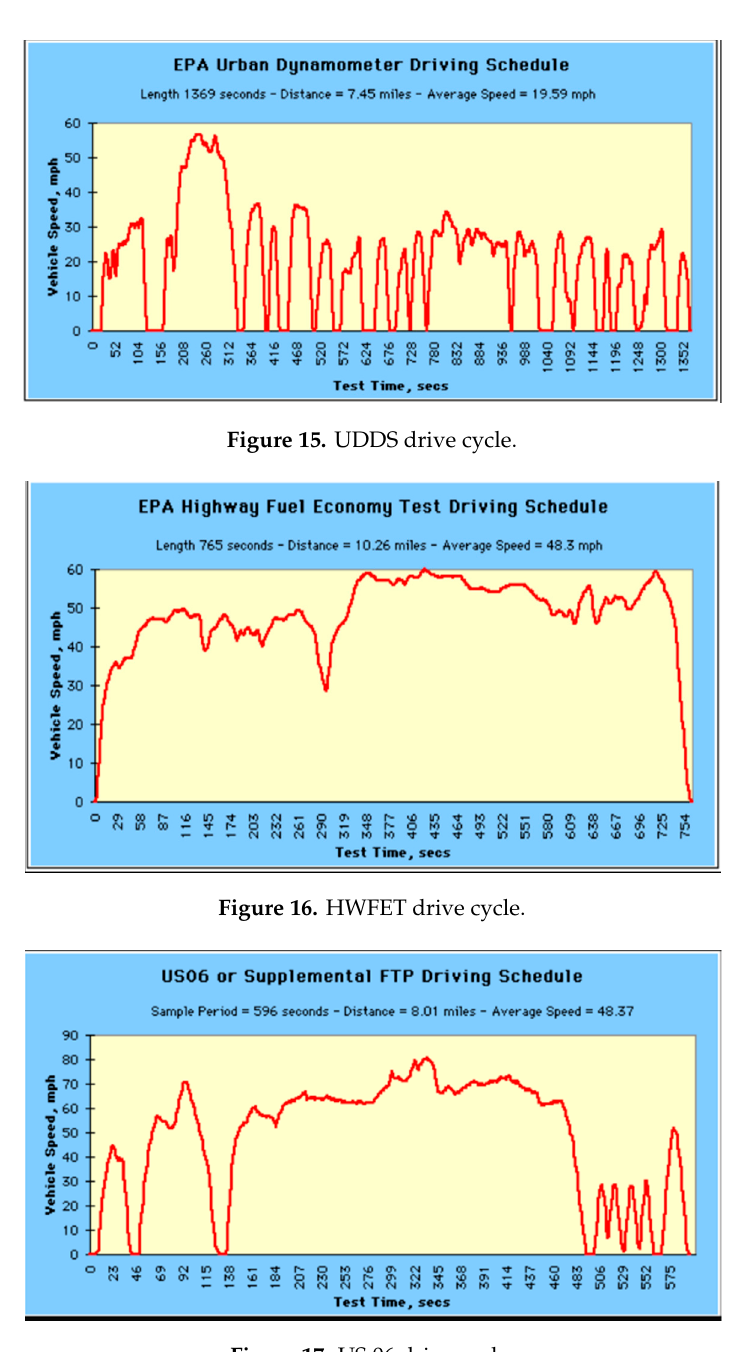
Table 4. Basic vehicle parameters.